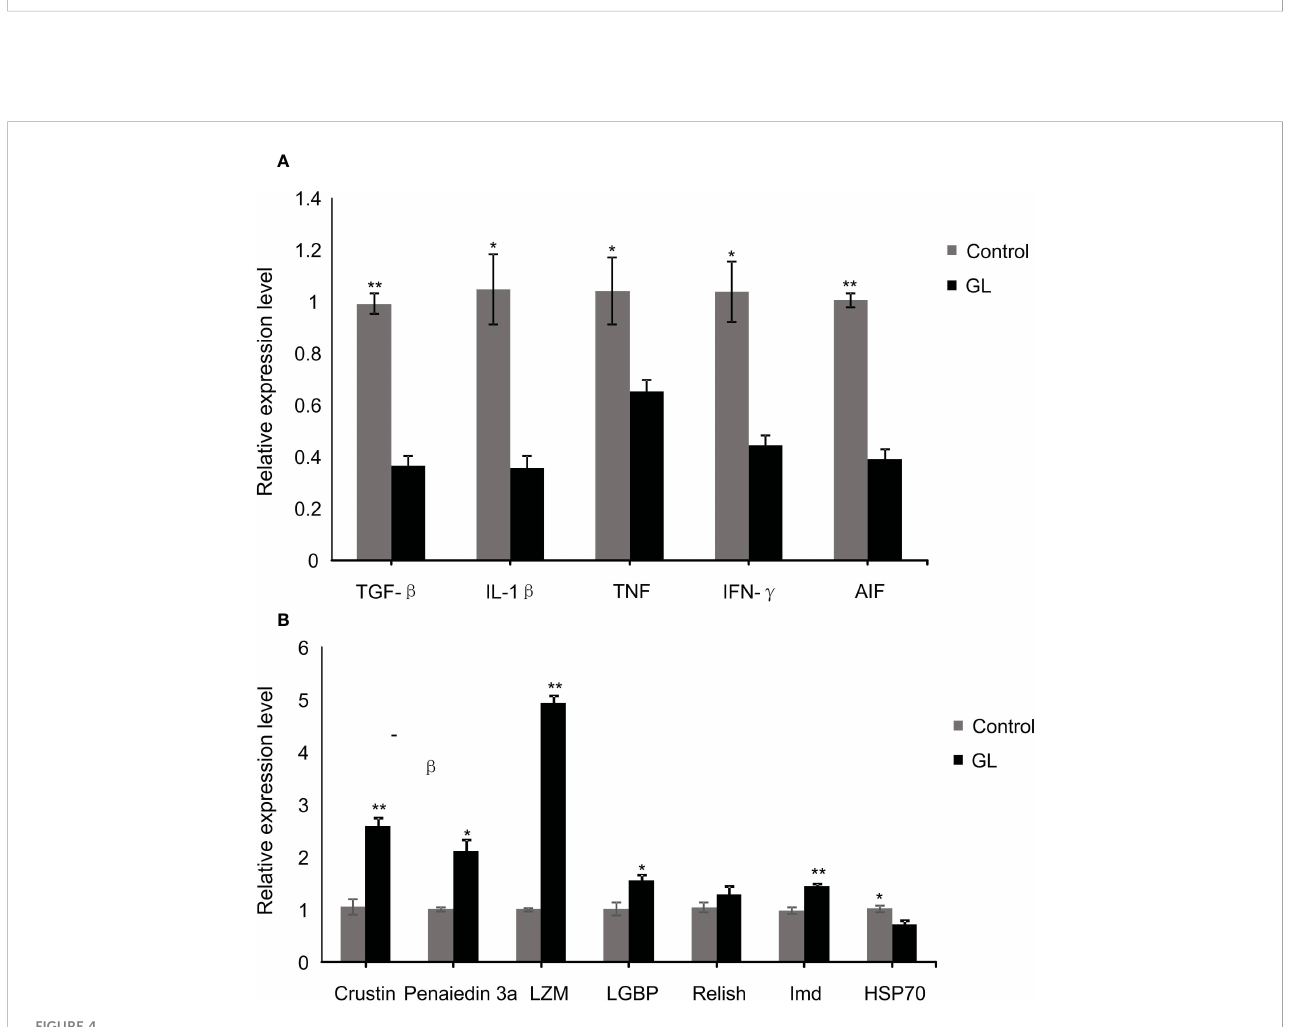
FIGURE 4 The relative mRNA levels of immune (A) and in fl ammation (B) related genes in intestinal tissue of Litopenaeus vannamei . * P < 0.05 , ** P < 0.01